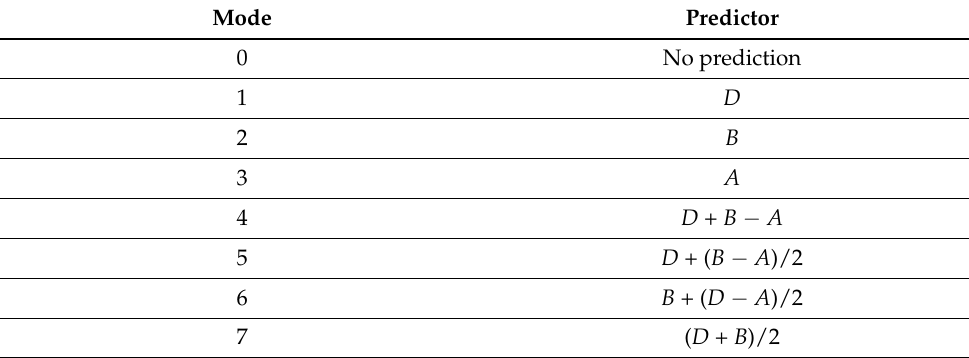
Table 3. Predictor for Lossless Joint Photographic Experts Group